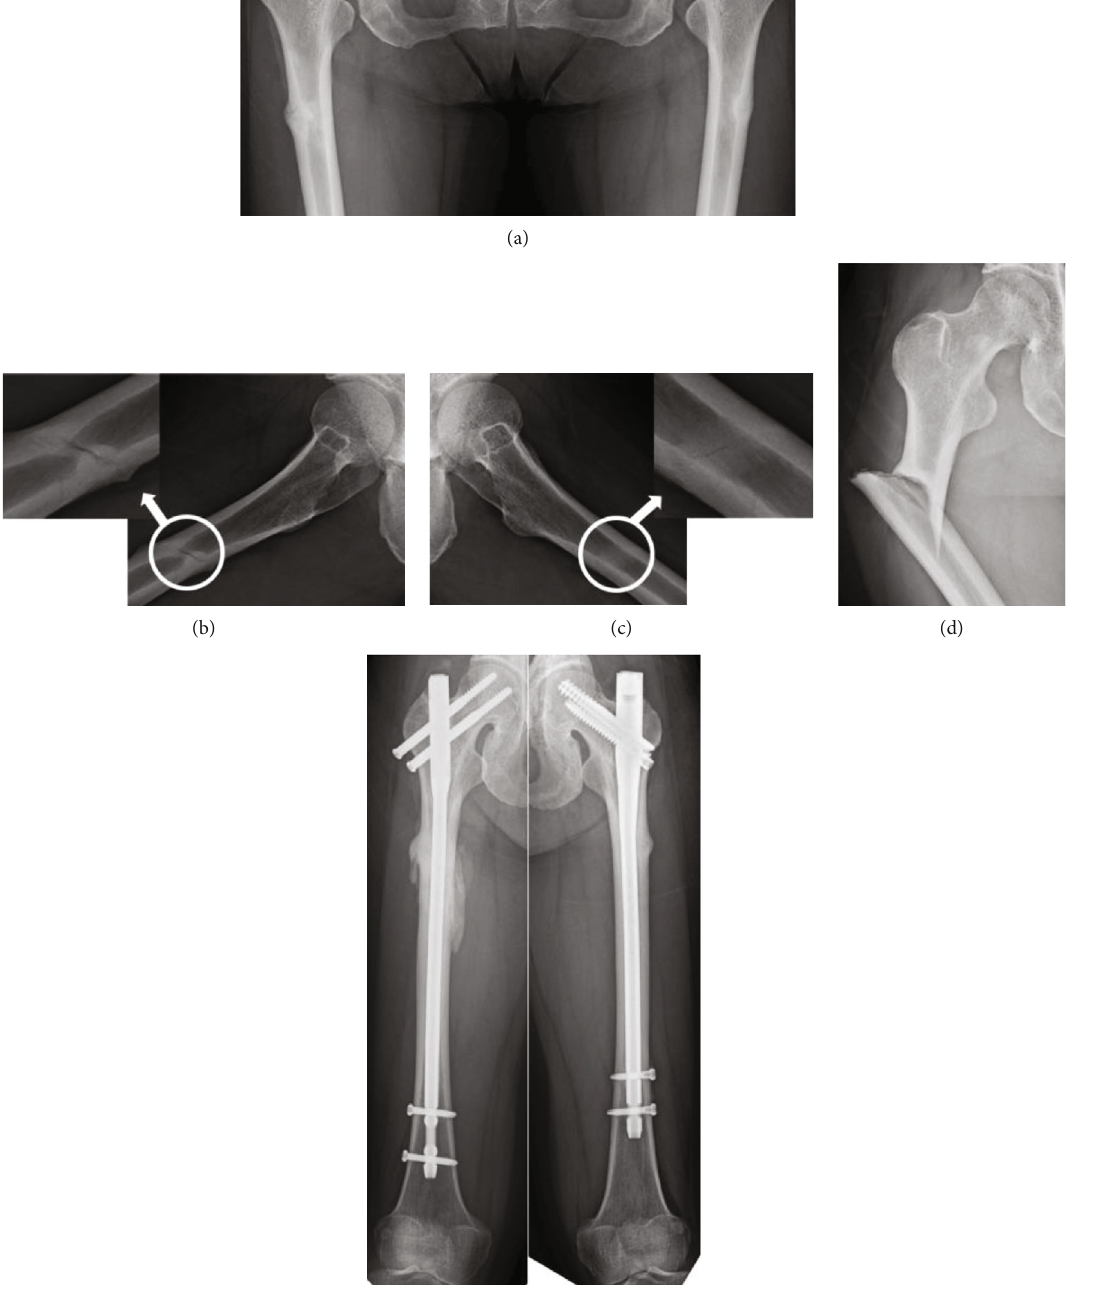
Figure 2: (a) The patient experienced bilateral thigh pain, and incomplete AFFs were detected. (b, c) Incomplete fracture lines, so called “ dreaded black lines, ” were clearly present on lateral view (circles; see magni fi cations). (d) The patient su ff ered a subtrochanteric AFF on the right side by falling. (e) Complete bone unions were achieved on the right and left sides at 24 and 15 months after surgery,